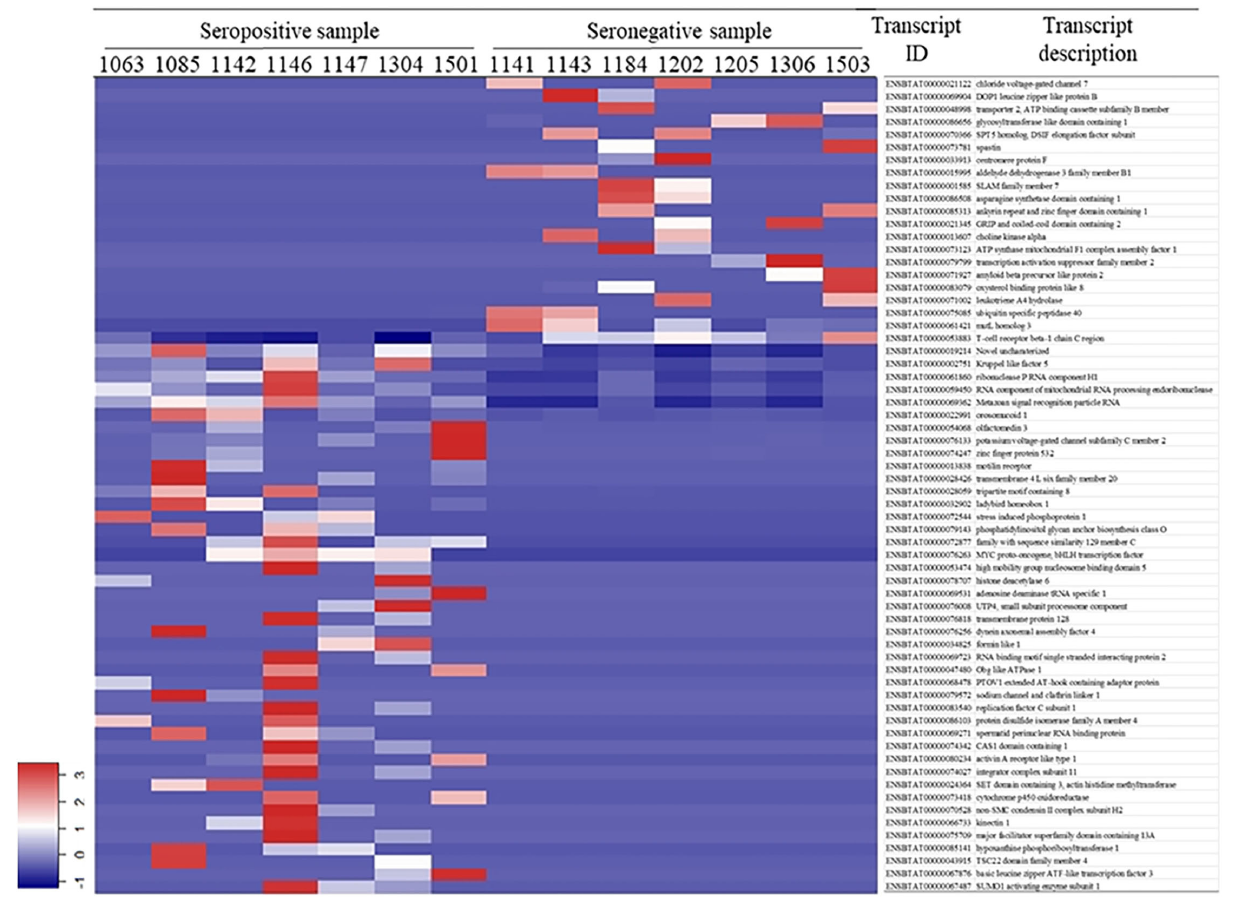
FIGURE 1 | Differentially expressed transcripts in white blood